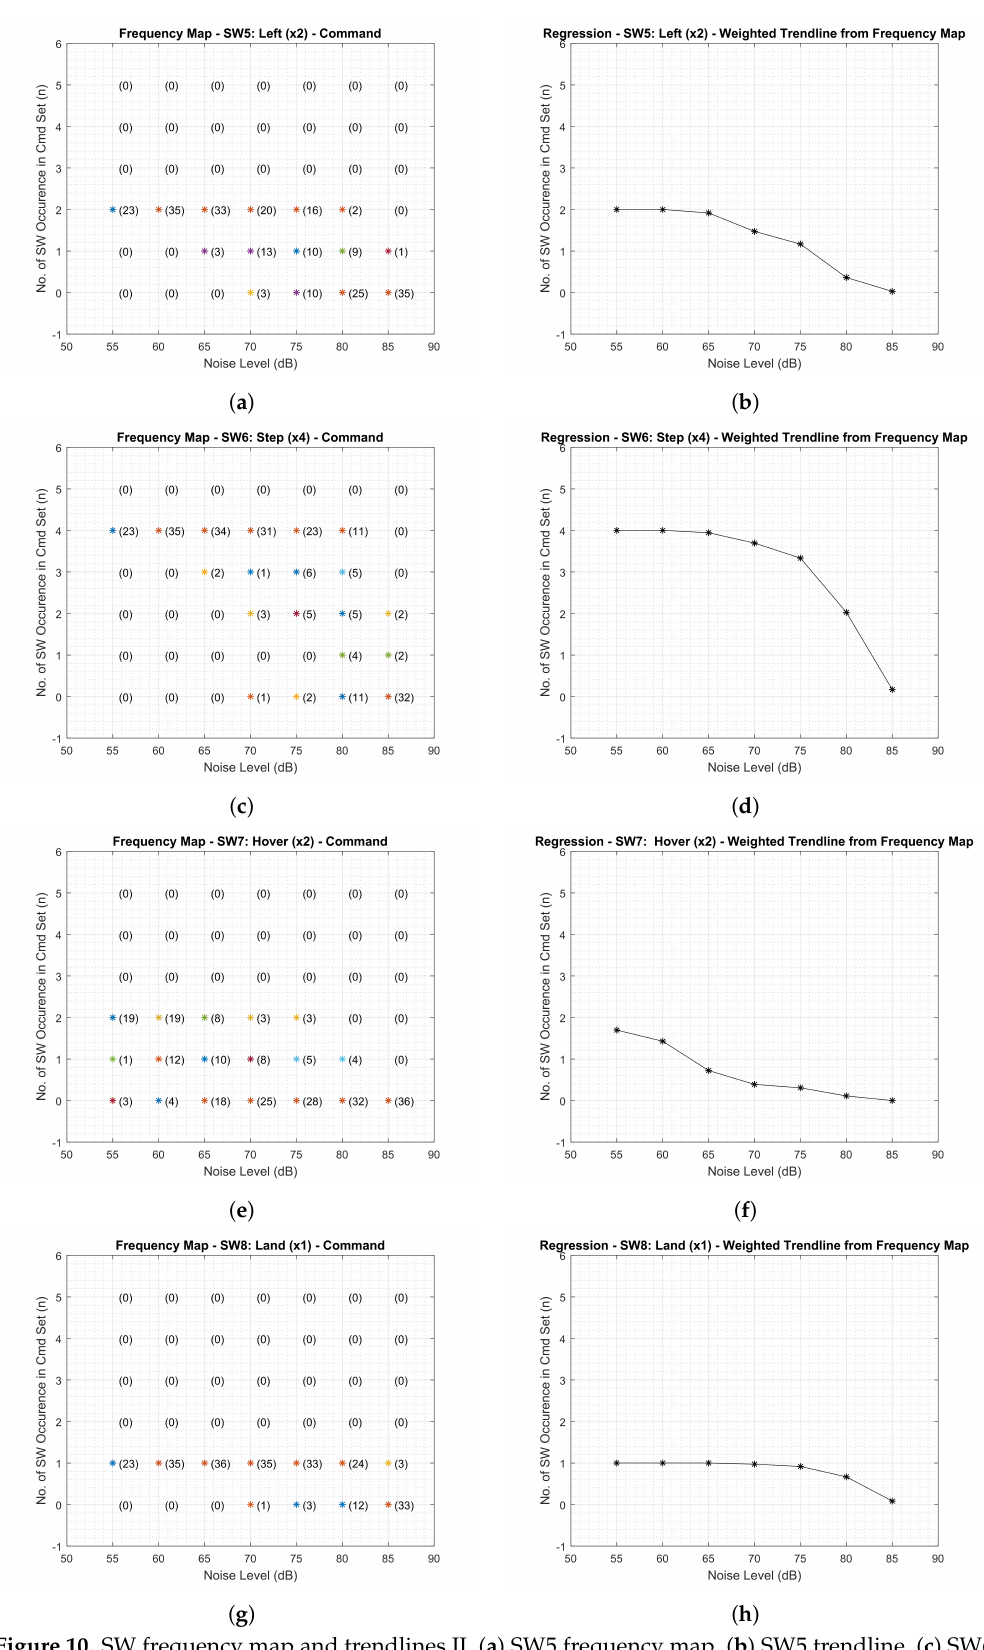
Figure 10. SW frequency map and trendlines II. ( a ) SW5 frequency map, ( b ) SW5 trendline, ( c ) SW6 frequency map, ( d ) SW6 trendline, ( e ) SW7 frequency map, ( f ) SW7 trendline, ( g ) SW8 frequency map, ( h ) SW8